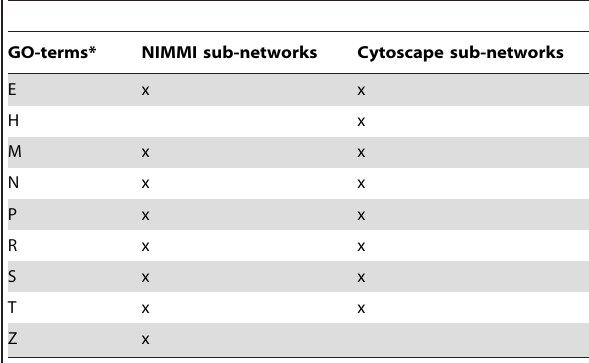
Table 1. NIMMI ’height prioritized sub-networks’ vs.